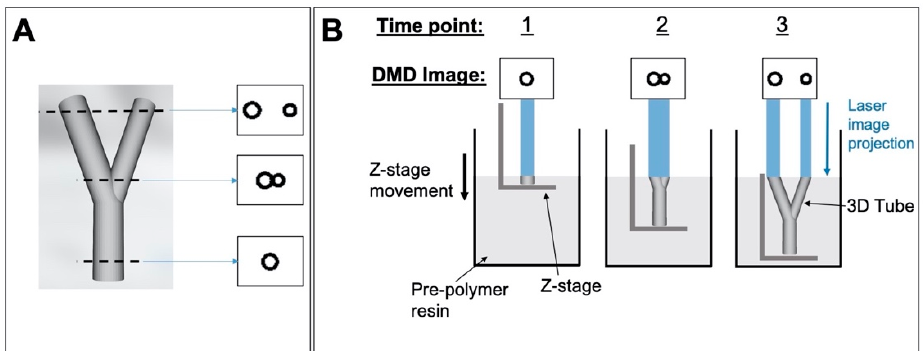
Figure 11. Production of 3D structures via microstereolithography. ( A ) 3D bifurcated tube designed in SolidWorks and three example cross-sectional images obtained from the ‘slicing’ process; ( B ) the process of curing a 3D tube by sequentially displaying the cross-sectional images on the DMD (three arbitrary time points shown.).